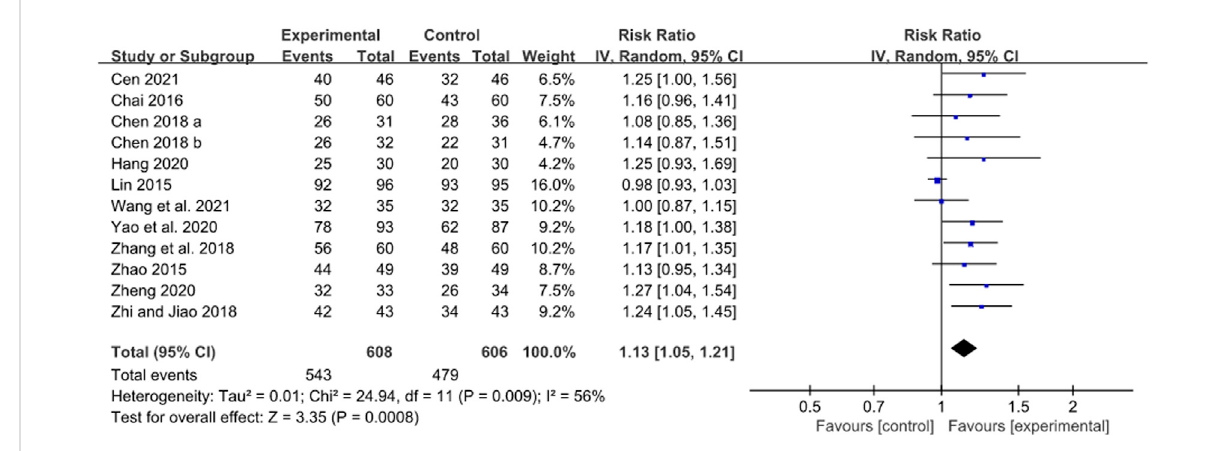
FIGURE 4 Forest plot of H. pylori eradication rate after JWC with the duration of 2 weeks.